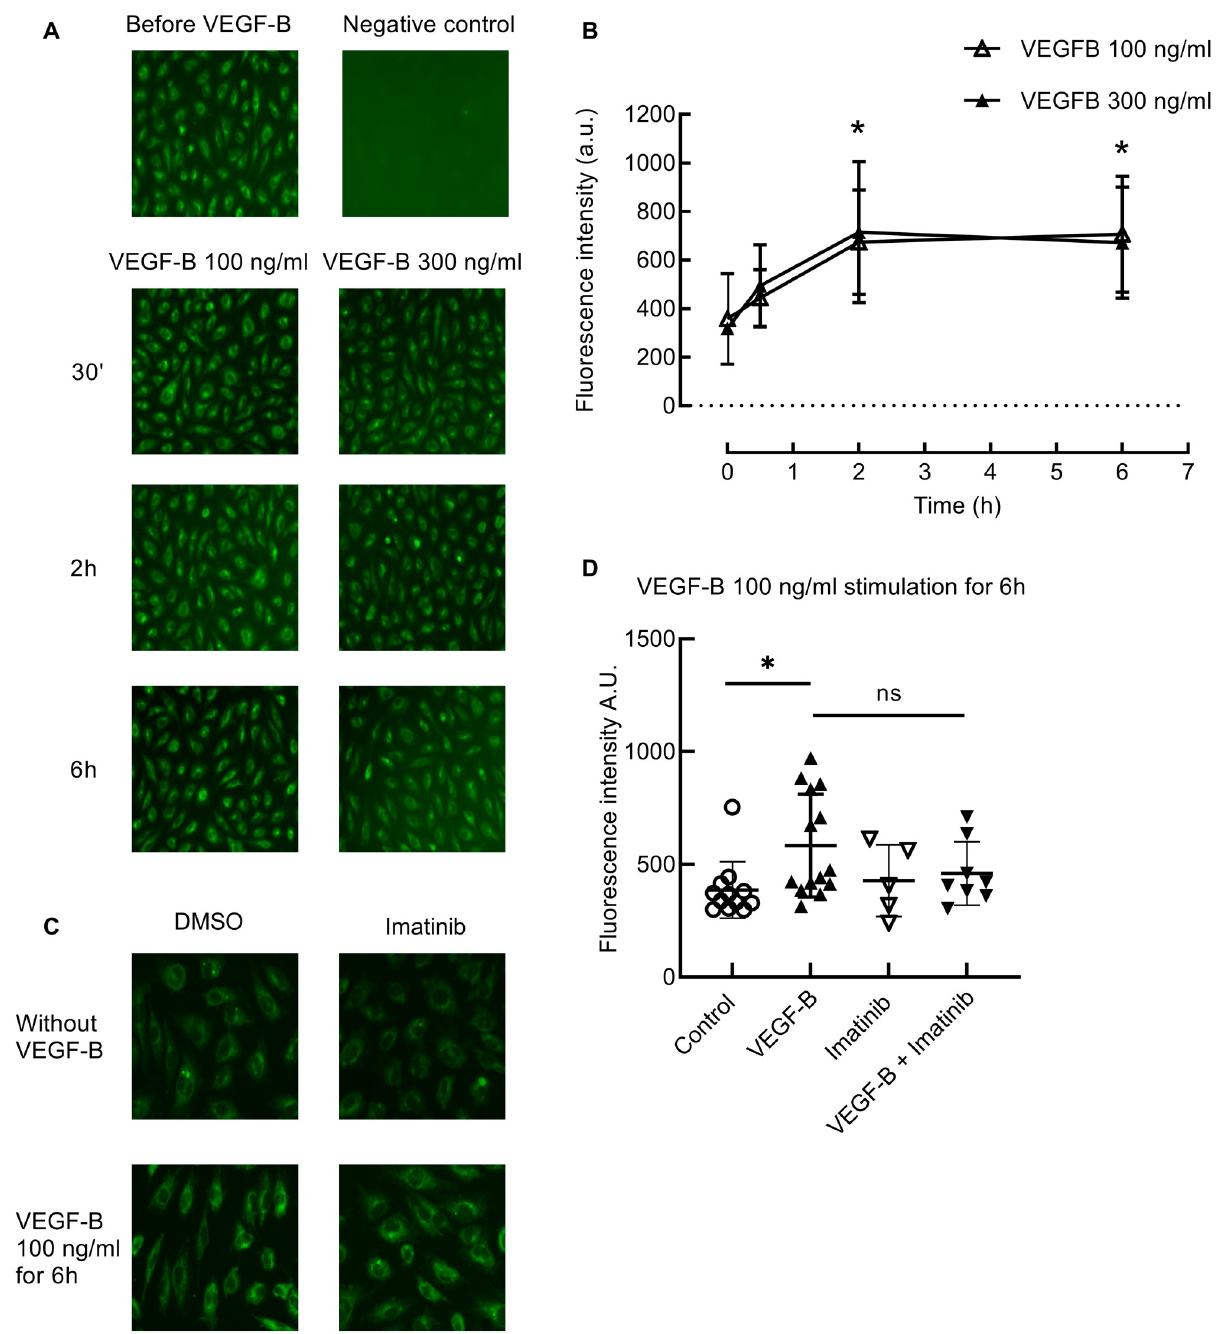
Fig 6. Effect of VEGF-B and imatinib on Bodipy-FA uptake into HUVECS. A: Bodipy-FA uptake in cells treated with VEGF-B 100 ng/ml and VEGF-B 300 ng/ml at different time points. B: Quantification of fluorescence in A. VEGF-B 100 ng/ml and 300 ng/ml caused a time-dependent increase in the uptake of Bodipy-FA at 2 hours ( P = 0.02 and P = 0.02) and 6 hours ( P = 0.01 and P = 0.03) of VEGF-B stimulation. � P in ordinary two- way ANOVA. a.u. = arbitrary units; n = 6. The data in this experiment are partly the same as the data in experiment Fig C, D. C: BODIPY-FA uptake into HUVECS treated with imatinib, with or without 6h 100 ng/ml VEGF-B stimulation. D: Quantification of fluorescence in B. Six hours stimulation with 100ng/ml VEGF-B caused an increase in the uptake of fatty acids in HUVECS. � P = 0.02 in ordinary one-way ANOVA. However, imatinib caused no decrease in Bodipy-FA uptake under basal and VEGF-B treated conditions. � P = 0.96 and P = 0.32 in ordinary one-way ANOVA. Non-significant (ns). N = 5–14.